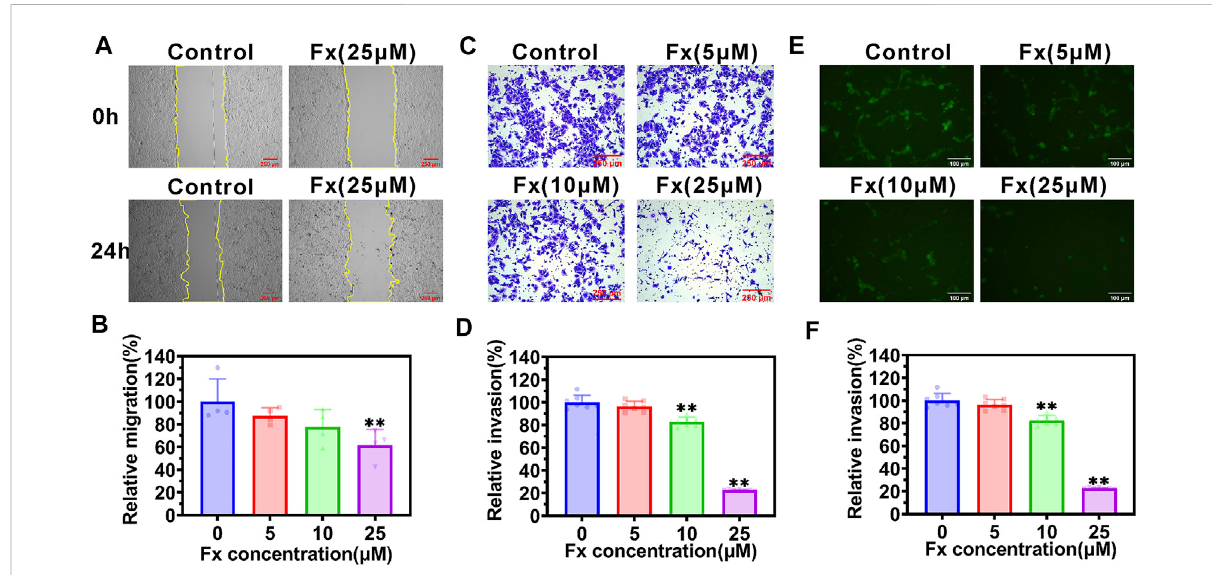
FIGURE 4 Fx inhibits migration, invasion, and transendothelial migration of MCF-7 cells. (A , B) Cell migration ability was determined by a wound-healing assay in MCF-7 cells treated with indicated concentrations of Fx for 24 h. The relative migration area was calculated as a percentage of control (Fx free). The yellow solid lines indicate the areas of migration. (C , D) Cell invasion ability was determined by transwell assay in MCF-7 cells treated with indicated concentrations of Fx for 24 h. The relative invasion rate was calculated as a percentage of control (Fx free). (E , F) Transendothelial migration analysis showed that Fx signi fi cantly inhibited the GFP-labeled MCF-7 cells (green) across the HUVECs. Data are presented as mean ± SD ( n = 3 – 6); ** indicate p < 0.01 vs . Control (Fx free).